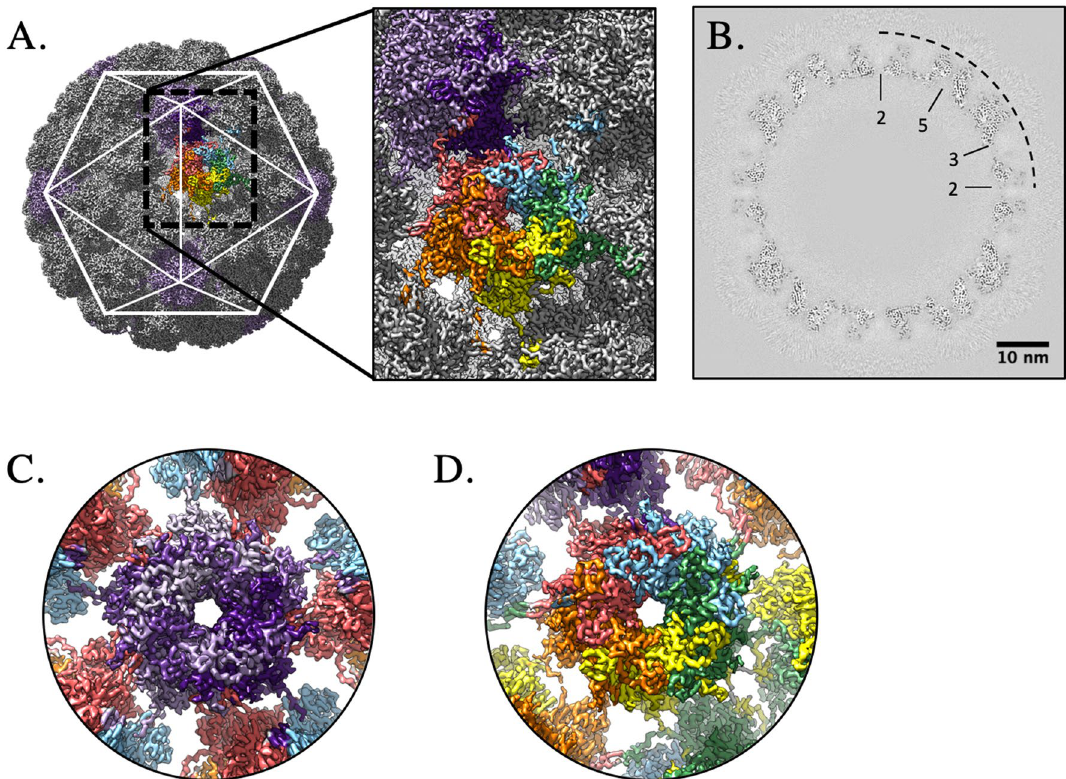
Figure 2. High resolution capsid map. The high resolution subparticle maps were recombined into a complete capsid (gray, surface rendered) ( A ), allowing the complete asymmetric unit ( A , inset, color code as in Fig. 1A) to be visualized in the context of the capsid (icosahedral cage). The high quality of the map is evident in the central section ( B ) with symmetry axes denoted (black dotted line) and scale bar. Density for individual L1 chains could be continuously traced in both the pentavalent ( C ) (L1 chain A; shades of purple) and hexavalent ( D ) capsomer maps (bottom right; L1 chains B–F; blue, green, yellow, orange, After refining the structures in each of the subvolumes, the six L1 chains were assembled into the asymmetric unit. This pdb was then validated against the recombined map (S. Table 1). The resolution allowed unambiguous placement of most sidechains (S. Figure 2) and presented continuous density for most of the termini. For the six chains of the asymmetric unit (Fig. 1A,B, chains A–F) there was strong continuous density stretching from Tyr12 to Arg485 (A), Val16 to Phe480 (B), Met1 to Phe480 (C & D), Leu3 to Gly483 (E), and Met1 to Gly483 (F) respectively. The refined structure superimposed with 5KEP with a C-alpha root mean squared deviation (RMSD) of 2.37 Å. The improved resolution of our map when compared to the previous 4.3 Å structure (Guan et al . ) allowed us to correct the 36 residues making up the C-terminal arm extensions (402–439) 22 . This map clearly resolved density corresponding to the Lys475 to Phe480 loop that was previously incorrectly assigned. N-terminal residues starting from Met 1, which had previously been unresolved, were now assigned for most of the chains in the asymmetric unit. Overall, the density in this map allowed clear assignment of residues and corrected the HPV16 L1 structure within the context of the icosahedral capsid. Each connecting arm has a different conformation. The pentavalent and hexavalent L1 capsomers